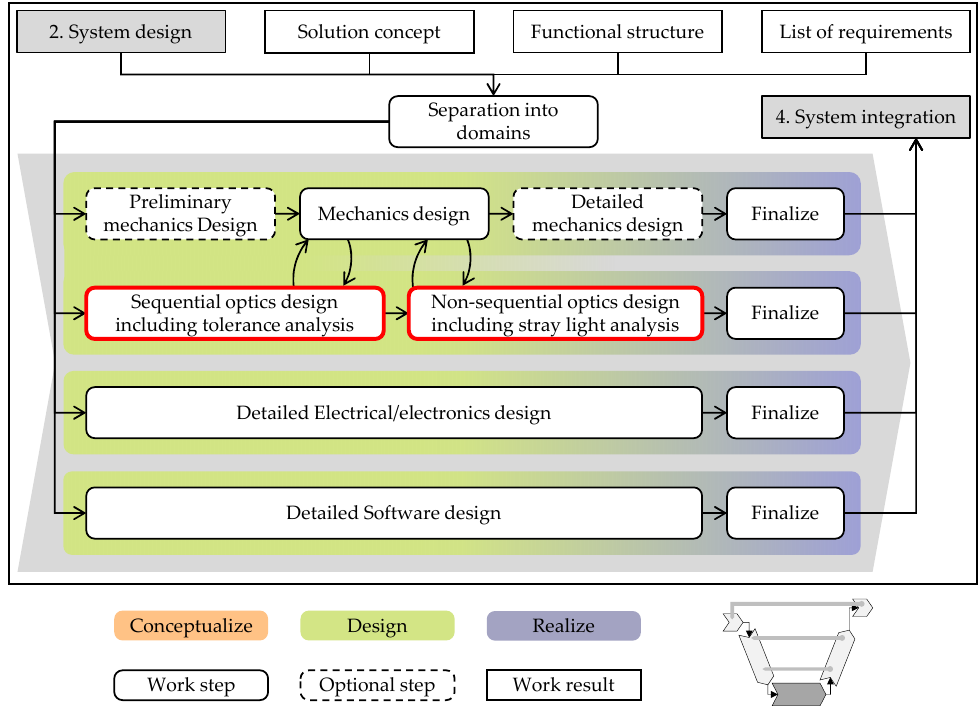
Figure 8. Process phase for the domain-specific design of optomechatronic systems according to [9] extended by the method for the sequential and non-sequential detailed design of high-resolution lighting systems according to